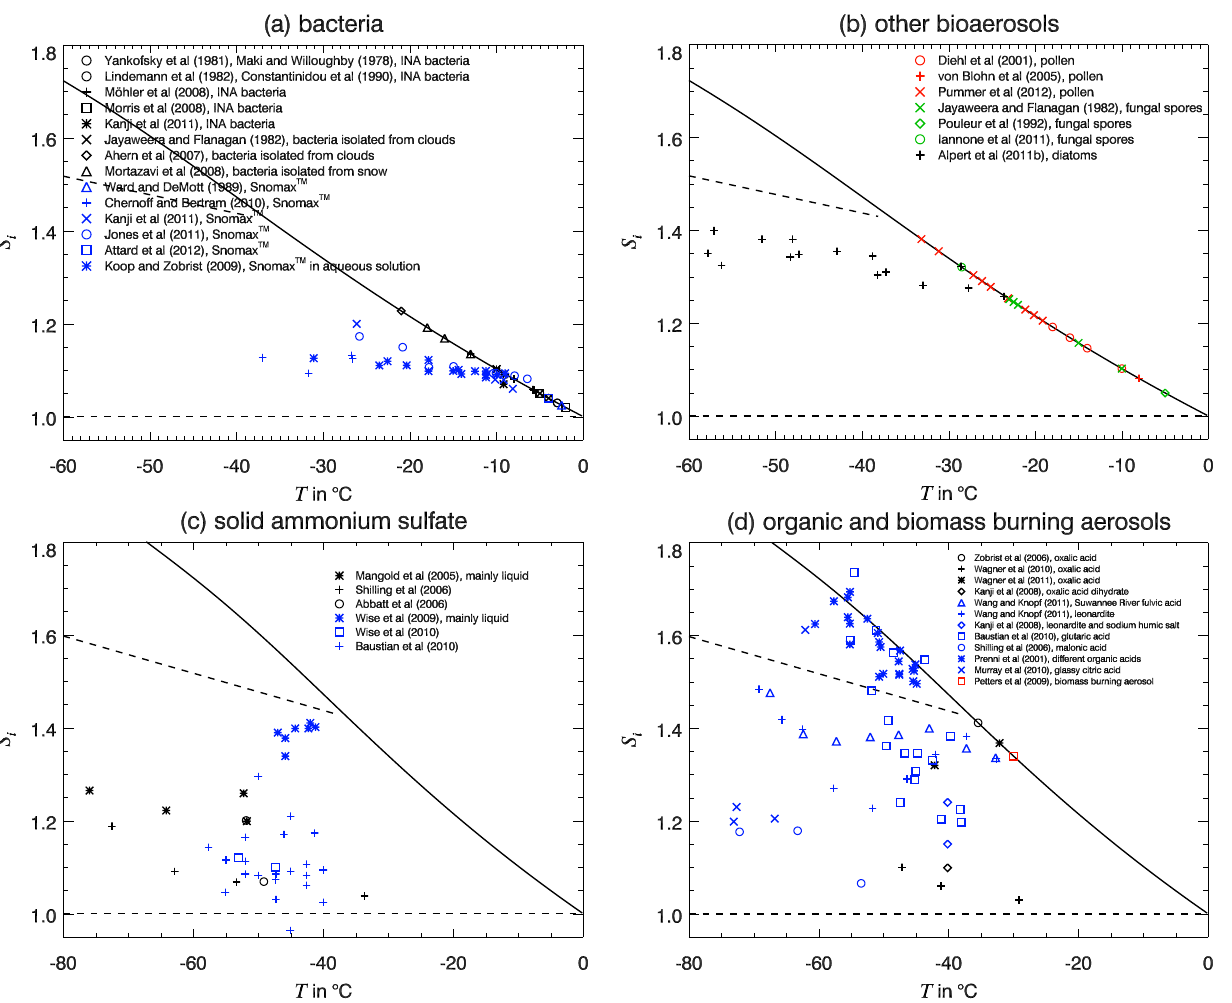
Fig. 5. Ice nucleation onset temperatures and saturation ratios for (a) bacteria, (b) other bioaerosols, (c) ammonium sulfate and (d) organic aerosols and biomass burning particles. Note the different temperature ranges. The data from Pummer et al. (2012) refer to median freezing